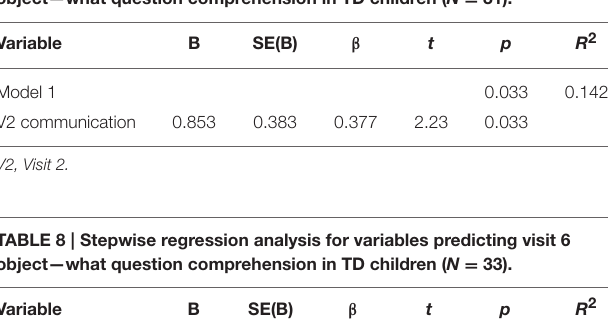
TABLE 7 | Stepwise regression analysis for variables predicting visit 5 object—what question comprehension in TD children ( N = 31).